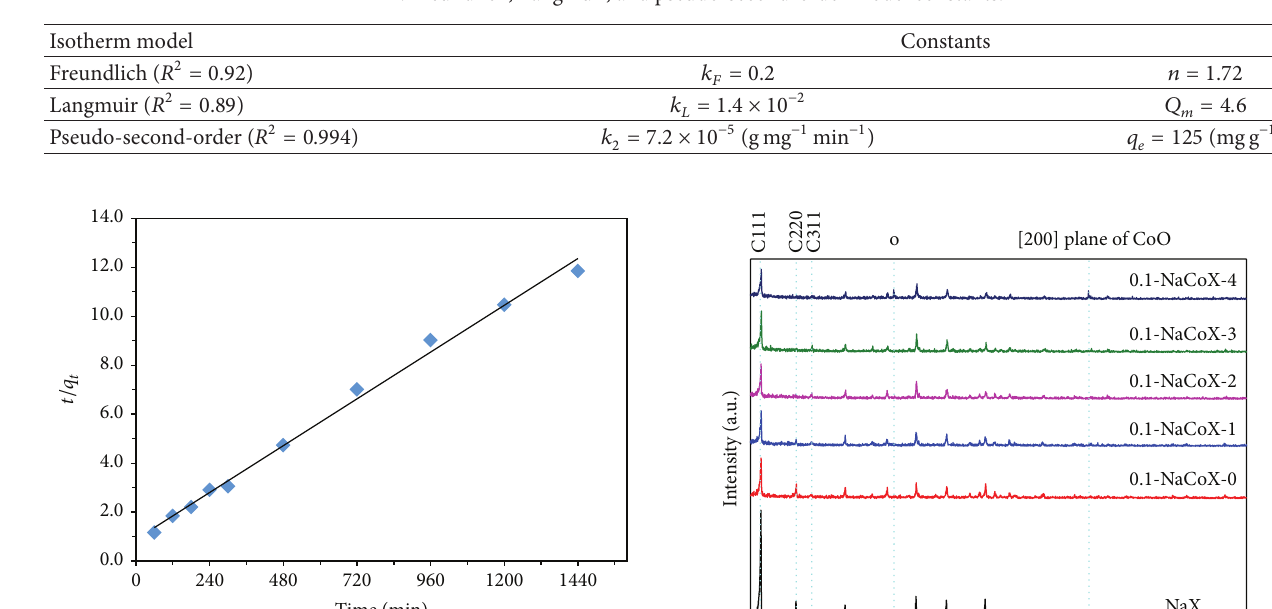
Table 1: Freundlich, Langmuir, and pseudo-second-order model constants.